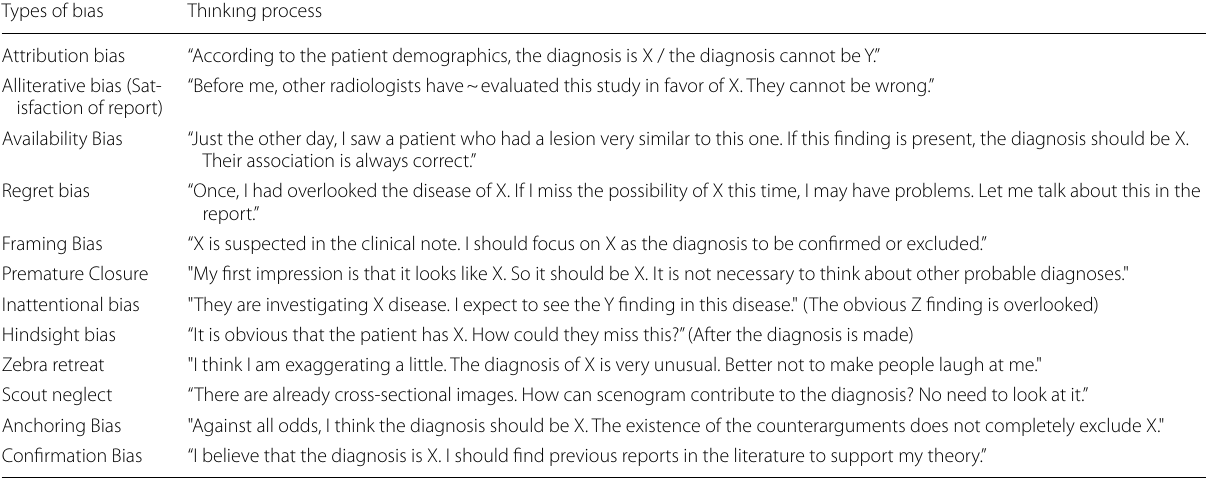
Table 2 Radiologists’ thinking processes based on types of bias Types of